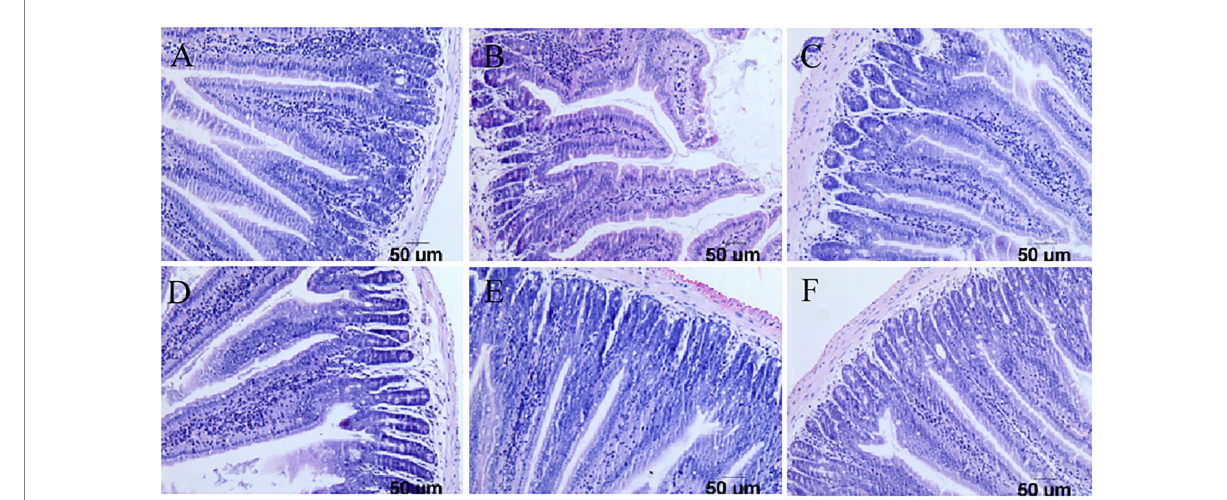
FIGURE 6 Pathological sections of the small intestine in mice. (A) Pathological sections of the small intestine in the PBS group. (B) Pathological sections of the small intestine in the challenge group. (C) Pathological sections of the small intestine in the antiviral drug group. (D) Pathological sections of the small intestine in the Pediococcus acidilactici group. (E) Pathological sections of the small intestine in the Lactobacillus casei group. (F) Pathological sections of the small intestine in the Lactobacillus paracasei group.